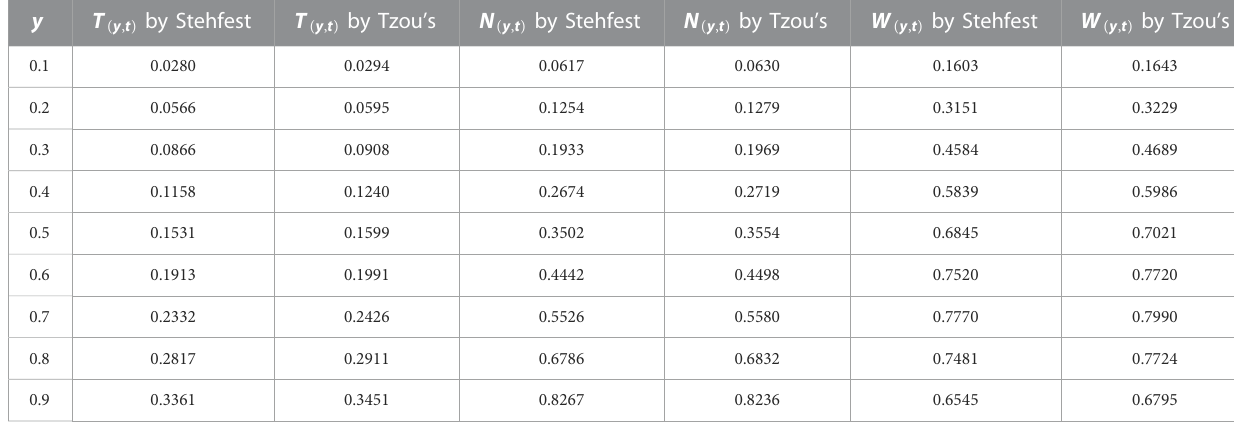
TABLE 3 Numerical analysis of numerical algorithms at different